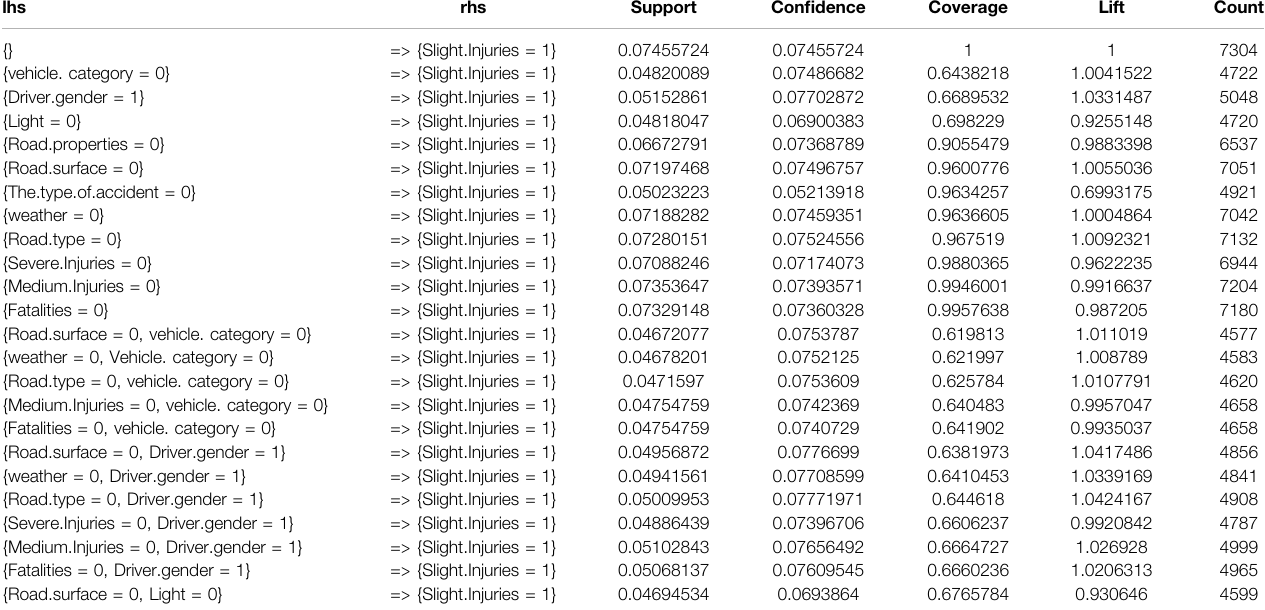
TABLE 4 | Slight injury results.